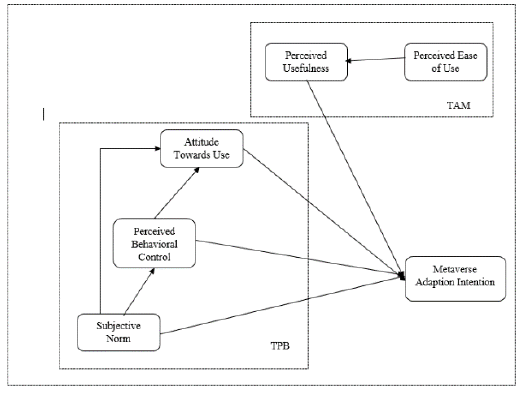
Figure 4. Conceptual Model